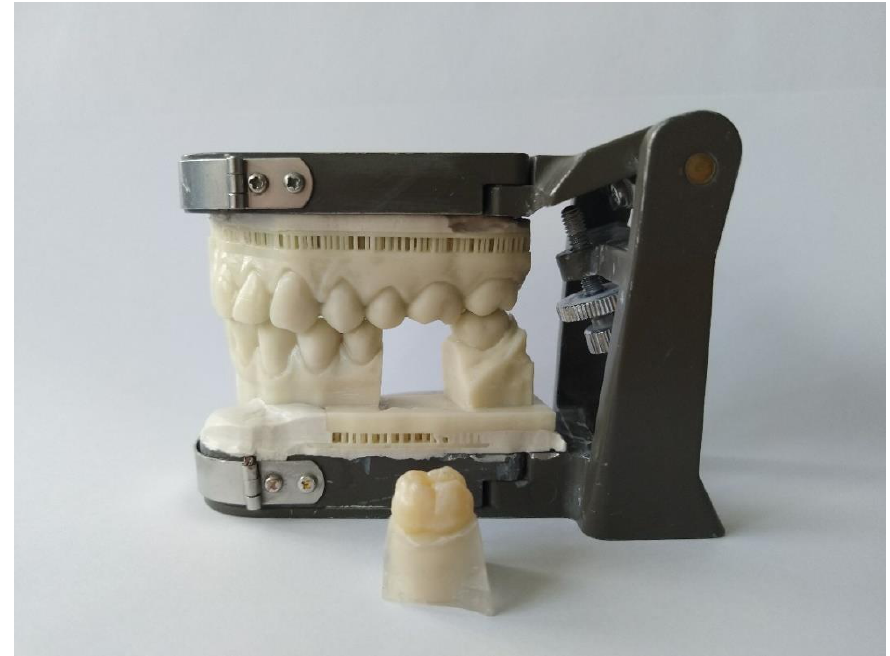
Figure 1. The test model with several interchangeable PMMA sockets and one of three different preparation geometries of the natural teeth ( n = 10). preparation geometries of the natural teeth ( n =